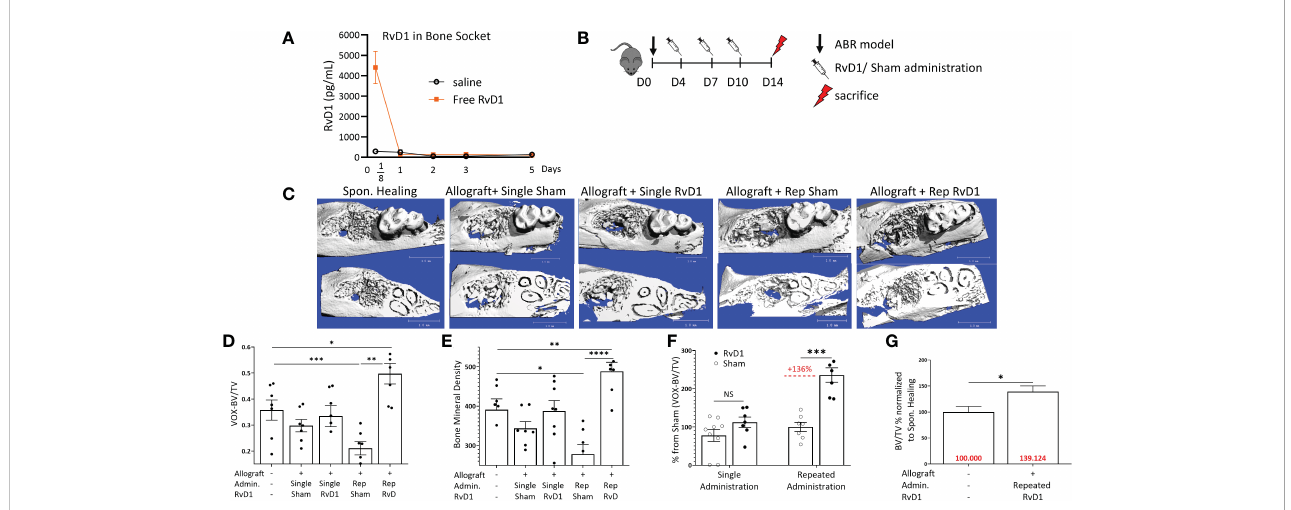
FIGURE 2 Rep-RvD1 improved bone healing. (A) RvD1 concentrations in bone sockets, in different time points (days) post ABR procedure (pg/mL) (n=4-6/group). (B) Experimental timeline: 8 weeks old male mice (C57BL n=7/group) were divided into fi ve groups. Control group mice were operated for ABR without allograft implantation (Spon. Healing), an experimental group of mice received allograft combined with RvD1 (60 ug/ml 15 ul) Allograft + single RvD1); the control group of allografts combined with saline (Allograft + single sham). Another experimental group of mice received allograft combined with RvD1 (60 ug/ml 15 ul), in addition to three more intra- palatal RvD1 injections (60 ug/ml 15 ul) in days 4, 7, 10 post-ABR (Allograft + Rep-RvD1), beside the control group which received allograft combined with saline (15 ul), followed with three more intra- palatal saline injections (15 ul) in days 4, 7, 10 post-ABR (Allograft + Rep-sham). All mice were sacri fi ced in 2 weeks post ABR procedure for radiographic analysis. (C) µCT 3- dimensional analysis of the regenerated alveolar bone, the occlusal plane of molars (above images), and the roots plane (below images). (D) Bone volume/total volume (BV/TV) numerical evaluation values for all groups. (E) Bone mineral density numerical evaluation for all groups. (F) BV/TV of RvD1 administration normalized the speci fi c control group (%). (G) BV/TV of rep-RvD1 administration combined with allograft normalized to the Spon. Healing control group (%). The asterisk symbol represents a statistical signi fi cance *<0.05; **< 0.01; ***< 0.005; **** <0.001